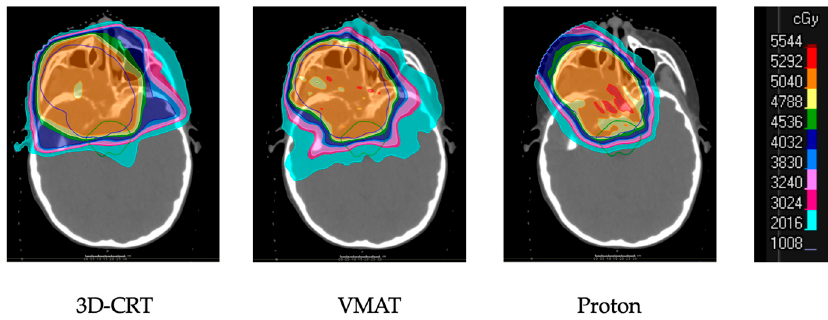
Figure 3. Comparison of plans for a parameningeal primary tumor using three-dimensional confor- mal radiation therapy (3D-CRT), volumetric arc-based therapy (VMAT), and proton therapy, showing improved dose conformality and sparing of normal tissue with proton therapy. Scale on the right shows dose in centigray (cGy).